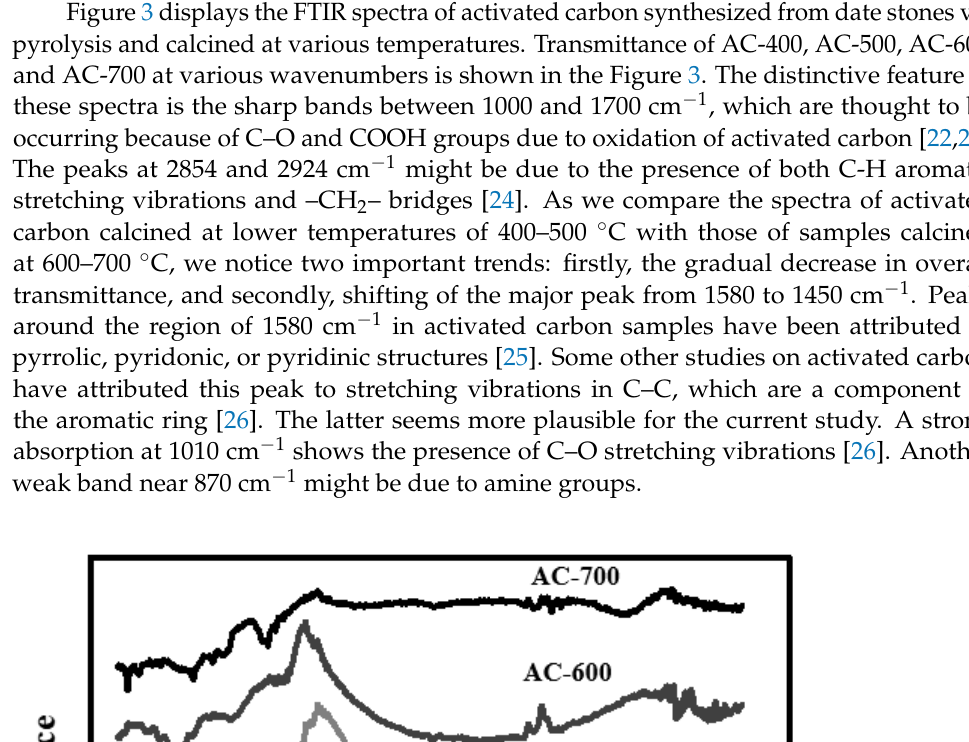
Figure 4. ( a ) XPS survey spectrum of various activated carbon-based catalysts; ( b ) high-resolution XPS spectra of Au. 3.3. Thermal Analyses (TGA-DTG and DSC)